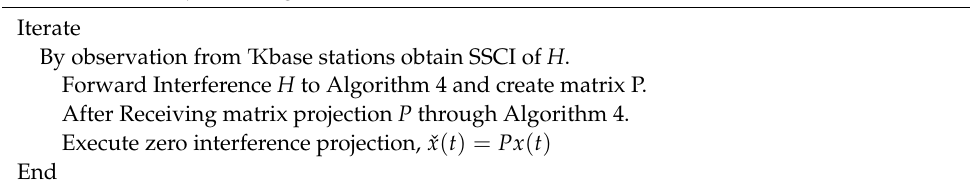
Algorithm 3 . Projection Algorithm 3 on 2nd